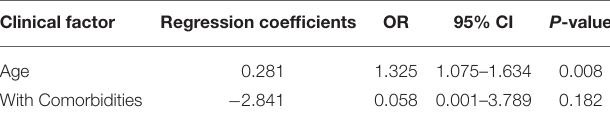
TABLE 8 | Multivariate analysis for the risk of disease severity in breast cancer patients with